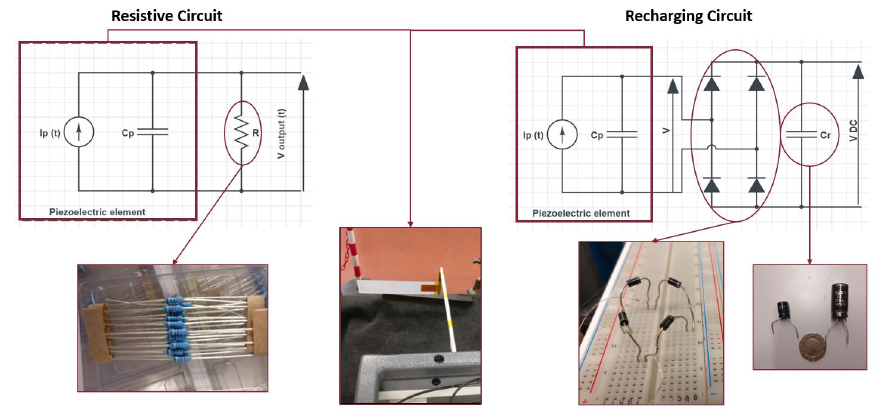
Figure 4. Al and PZT attached flags used for energy harvesting in subsonic wind tunnel.